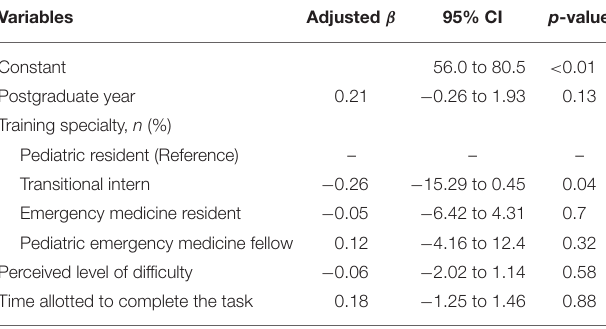
TABLE 2 | Multiple regression analysis of the Japanese version of the pediatric emergency medicine script concordance test